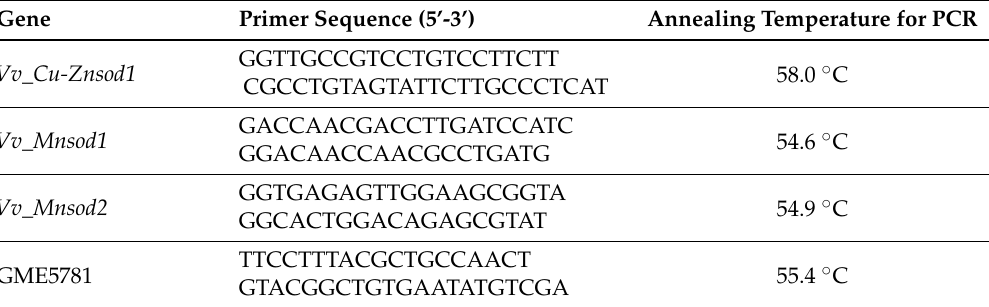
Table 1. Gene-specific primers used to amplify the full-length DNA sequences.